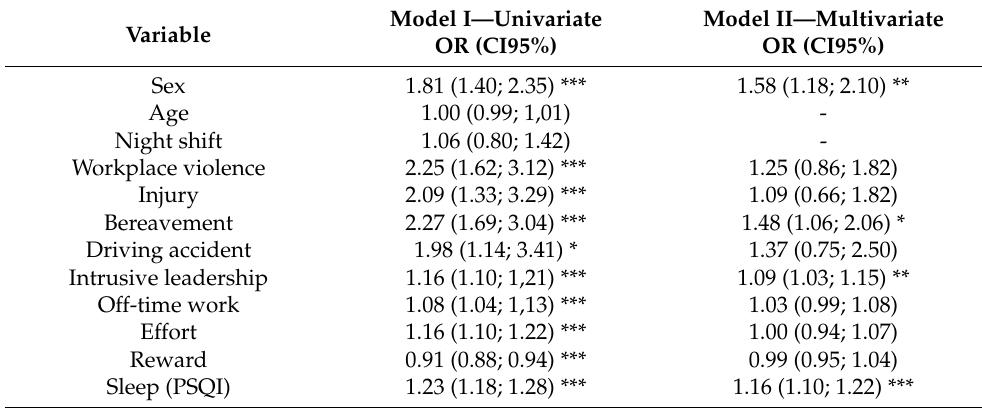
Table 1. Association of individual and occupational variables with headache occurrence. Logistic regression analyses.